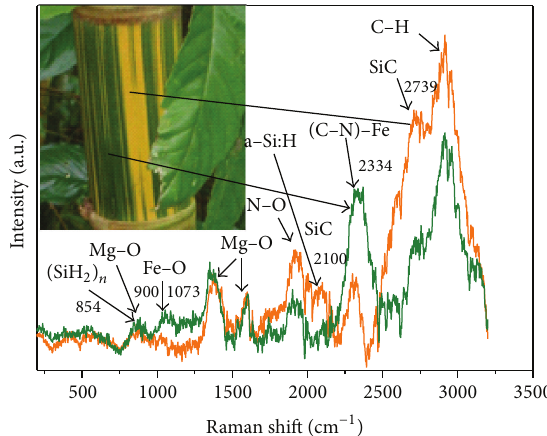
Figure 3: Raman spectra of the green and yellow zones in the outer wall of GAKVB.